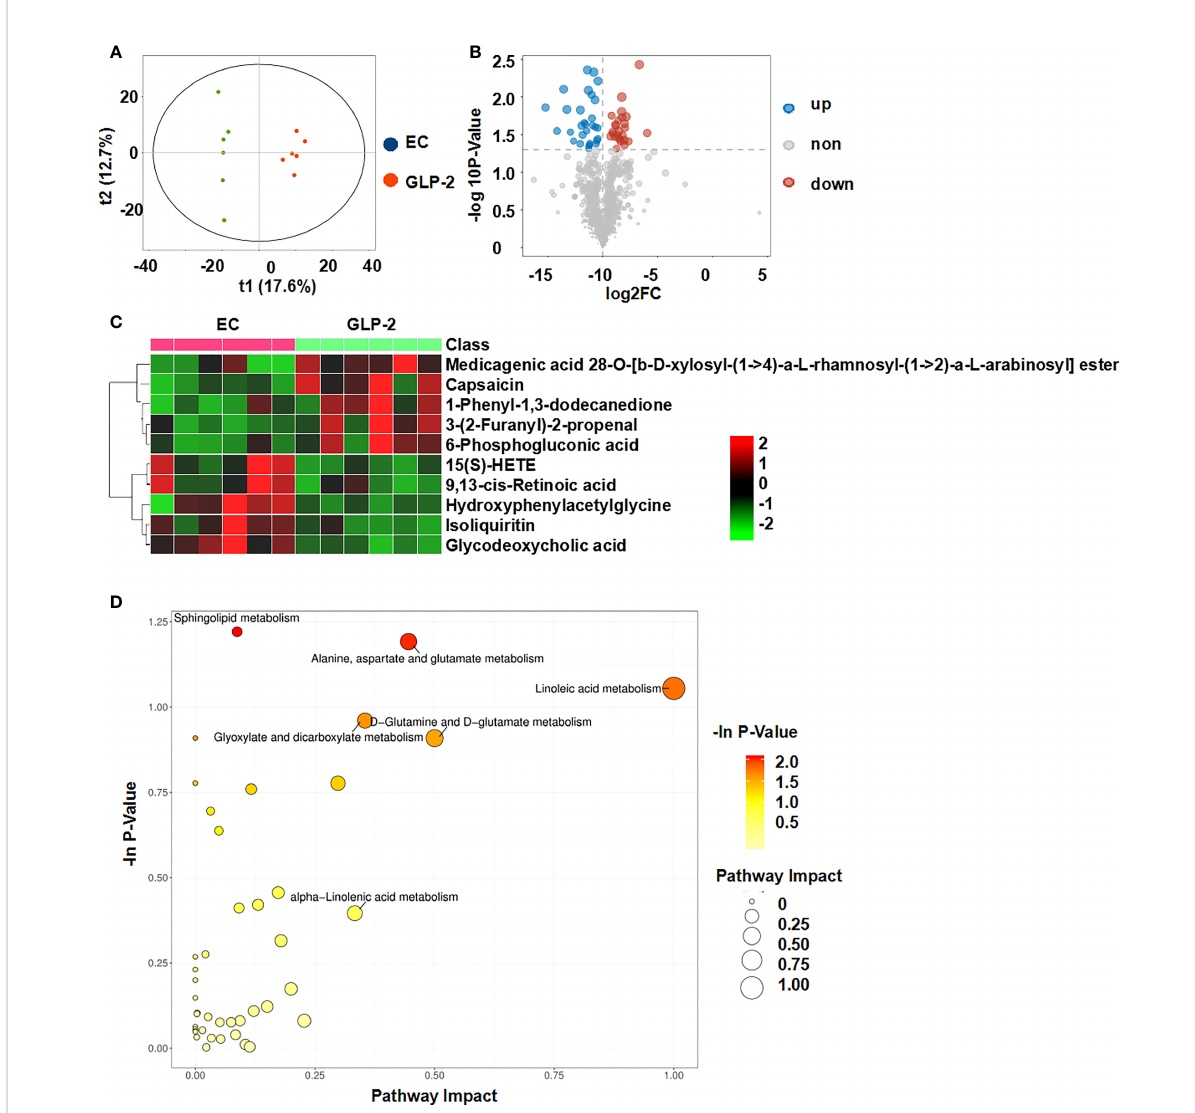
FIGURE 5 Metabolomic analysis of the serum of rats after GLP-2 treatment. (A) Score plots of the orthogonal projections to latent structure-discriminant analysis (OPLS-DA) model for the EC and GLP-2 groups. (B) Volcano plot of differential metabolites. (C) Community heatmap of the differential metabolites. (D) Bubble plots of pathway analysis between the EC and GLP-2